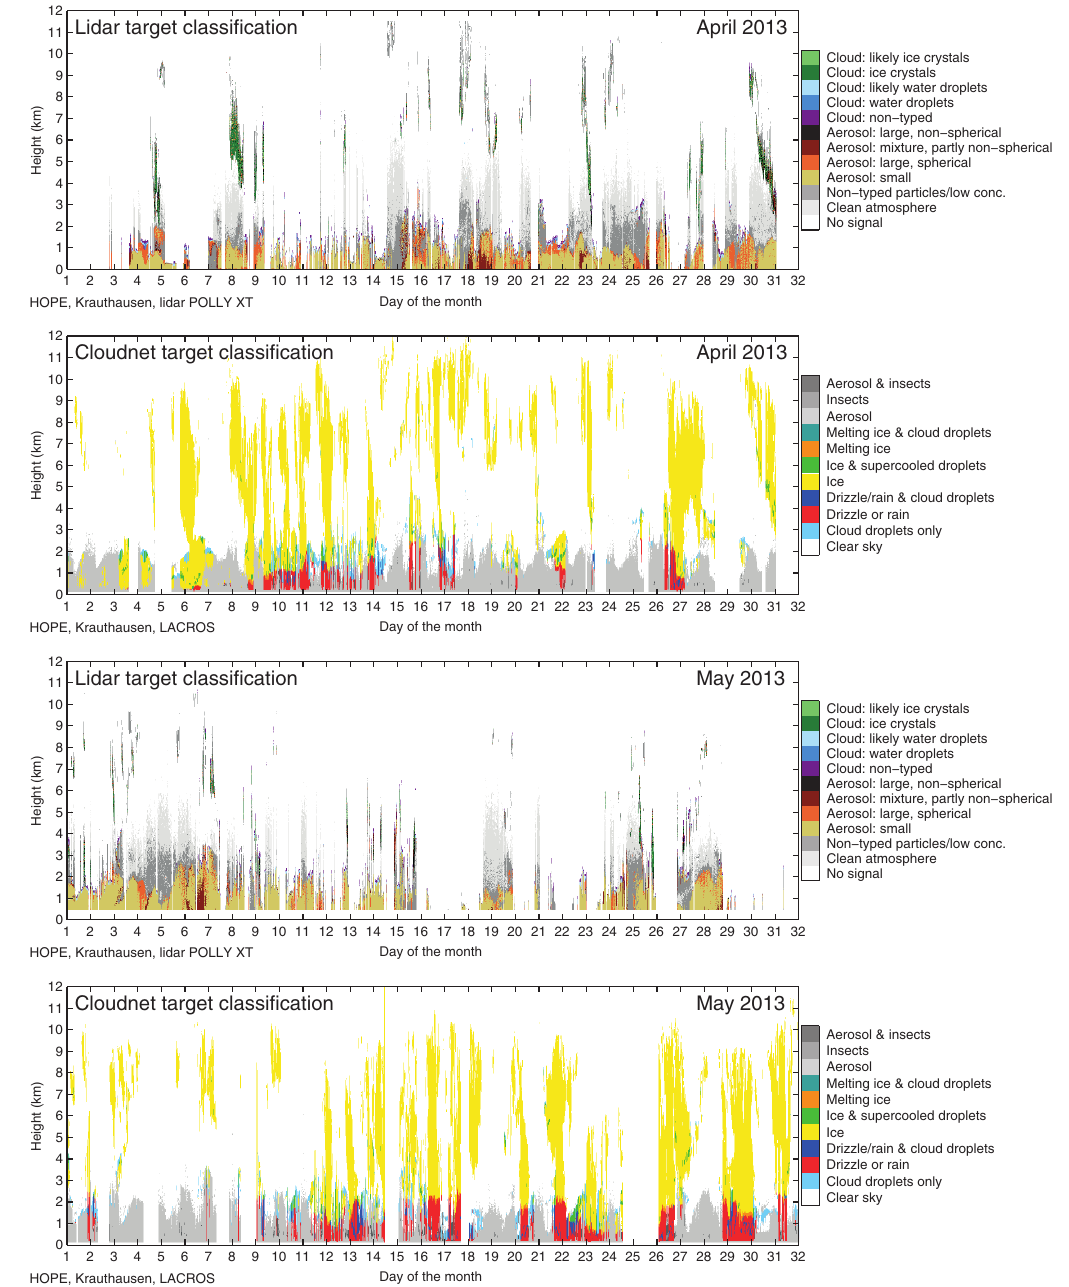
Figure 14. Lidar particle categorization and Cloudnet categorization for April (top) and May (bottom) 2013.